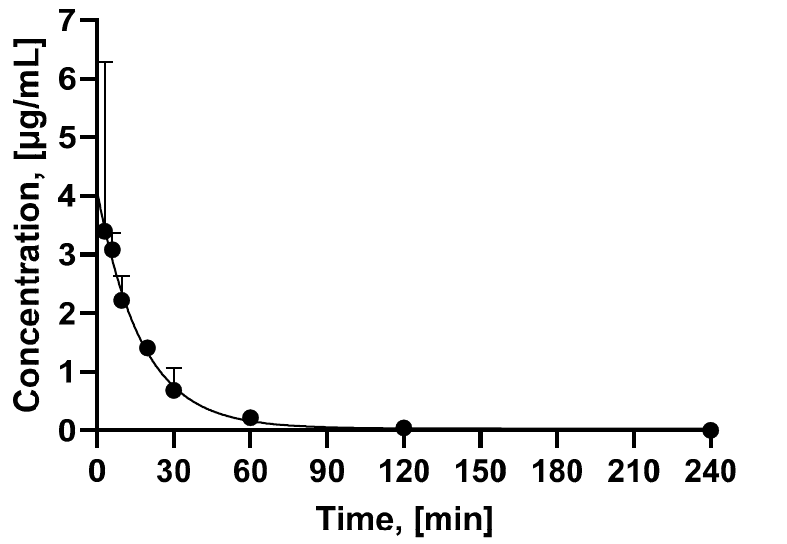
Figure 1. Plasma concentration of Ga-C803-GIP measured at 3, 6, 9.6, 19.8, 30, 60, 120, and 240 min post subcutaneous administration in rats ( n = 3). The error bars are not seen due to the low SD values. The plasma concentration of Ga-C803-GIP was below the limit of detection at the 240 min time point and was assigned zero value. Table 2. The potency of the half-maximal effective concentration (EC 50 , [pM]) for C803-GIP, Ga- C803-GIP, S02-GIP-T4, and Ga-S02-GIP-T4 measured in HEK293 cells transfected with the GIPR, GLP1-R, and GCGR.